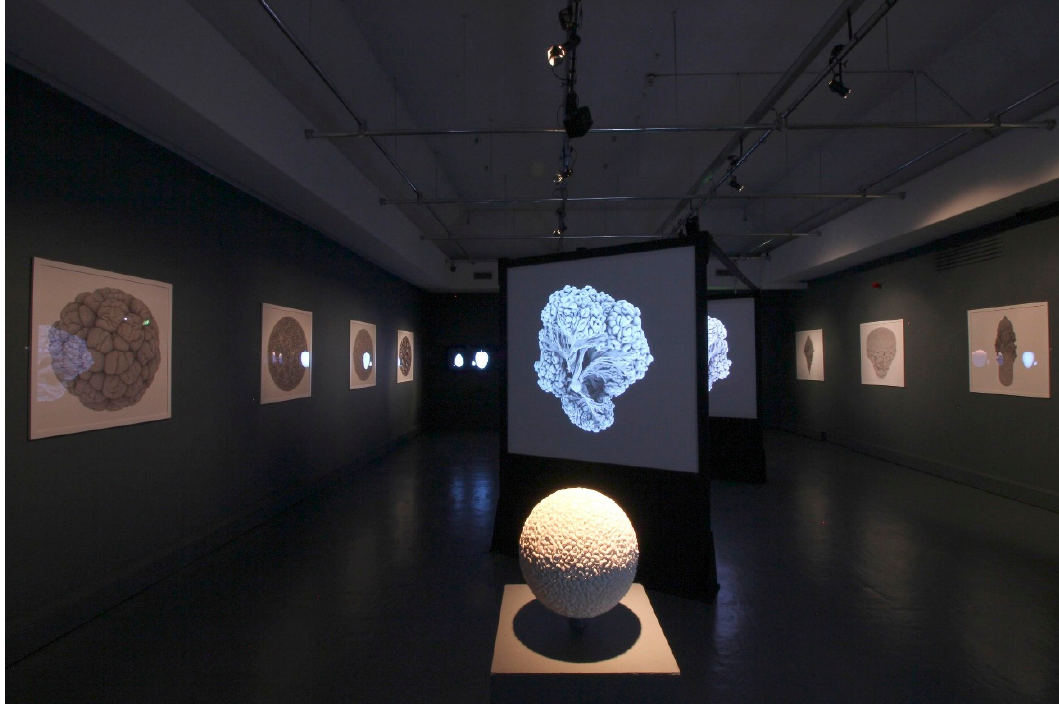
Figure 4. Morphogenetic Creation exhibition at Watermans, 2016. All works in the exhibition were created using Species Explorer to discover parameter values for the forms presented.